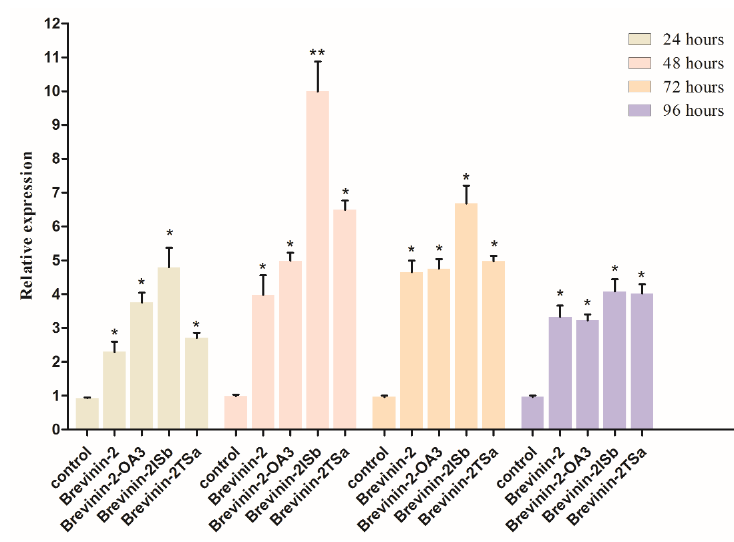
Figure 5. The relative gene expression of lys-7 in C. elegans after treatment with four Brevinin-2 family peptides. Compared with control group OP50, * means p < 0.05, ** means p < 0.01.